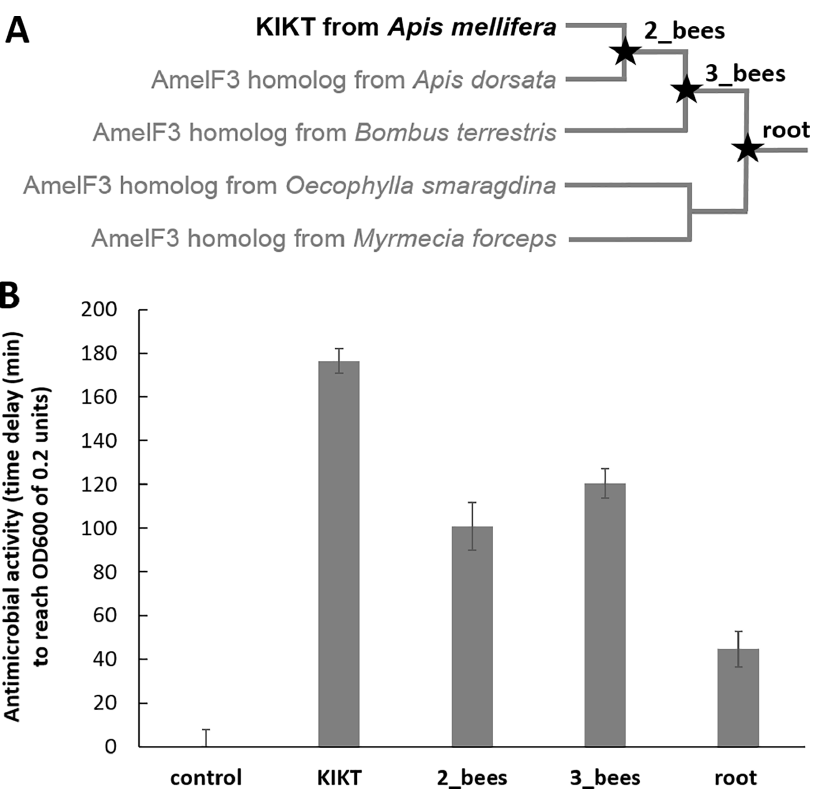
Fig 2. Testing the antimicrobial activity of the KIKT peptide from ancestral and extant sequences homologous to AmelF3 from honeybees. A. Phylogenetic tree of bee species within the Hymenopteran suborder Aculeata with black typeface indicating extant and ancestral sequences used in the analysis. Full protein sequences can be found in S2 Table. B. Comparative antimicrobial activity of the various peptides expressed as the time delay (min) for an E . coli culture to reach an optical density at 600 nm (OD600) of 0.2 units. NB. The peptides generated from ancestral sequences contained a higher proportion of hydrophobic residues and precipitated from solution during the assay period. Error bars show the standard error of the mean calculated from four separate growth